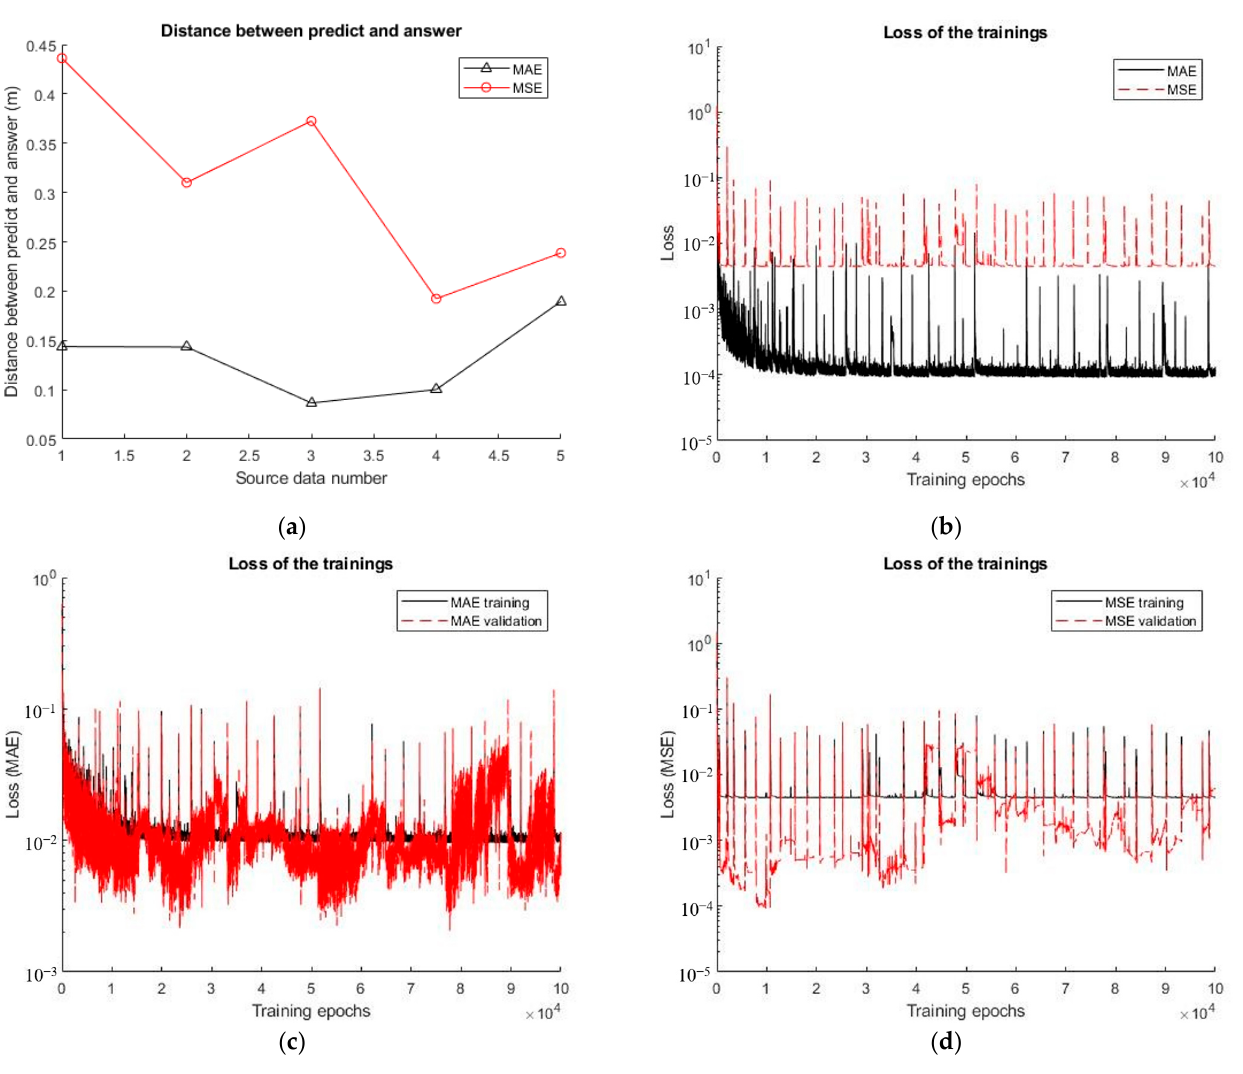
Figure 18. ( a ) Prediction results obtained in the universal applicability test. ( b ) Training epochs obtained when using the MSE and MAE were used as the loss function in testing. ( c ) Verification training epochs obtained when using the MAE as the loss function in testing. ( d ) Verification training epochs obtained when using the MAE is used as the loss function in testing.